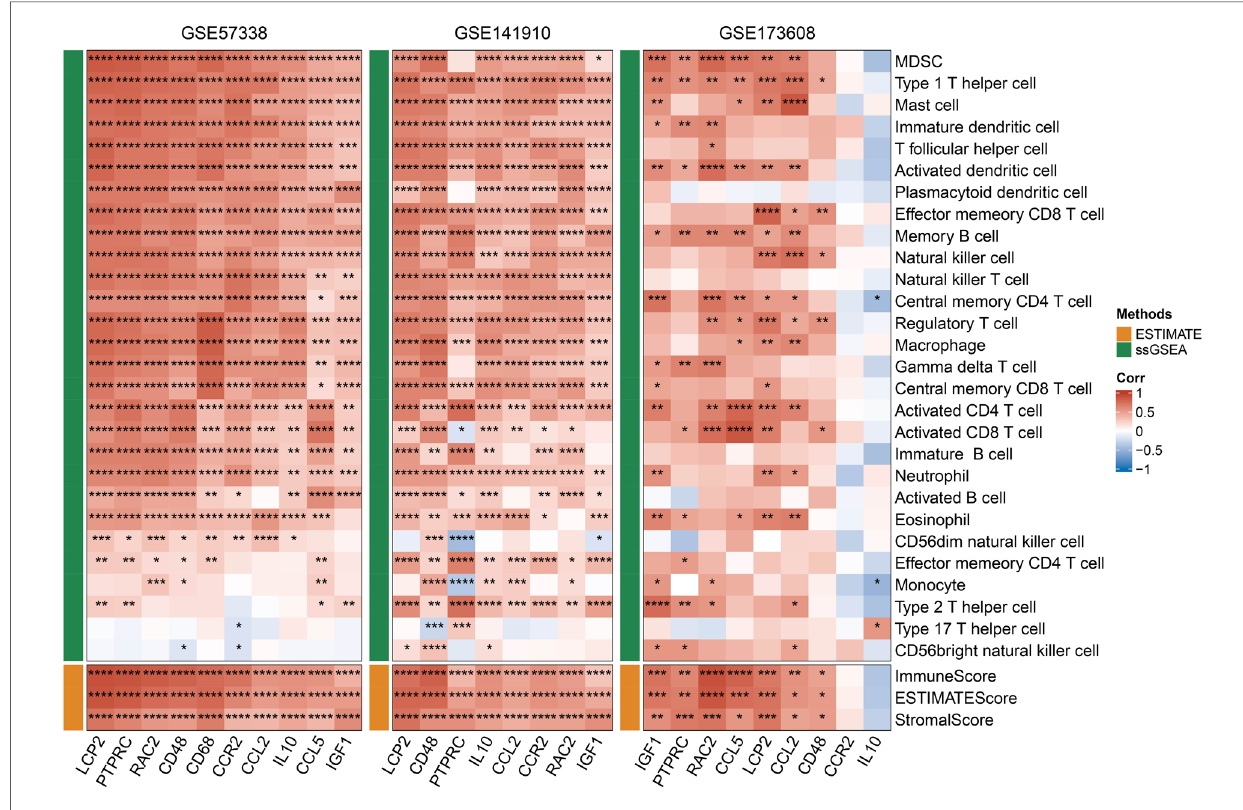
FIGURE 7 Correlation between hub genes and immunity, red represents positive correlation, blue represents negative correlation, * p <0.05, ** p <0.01, *** p <0.001, **** p